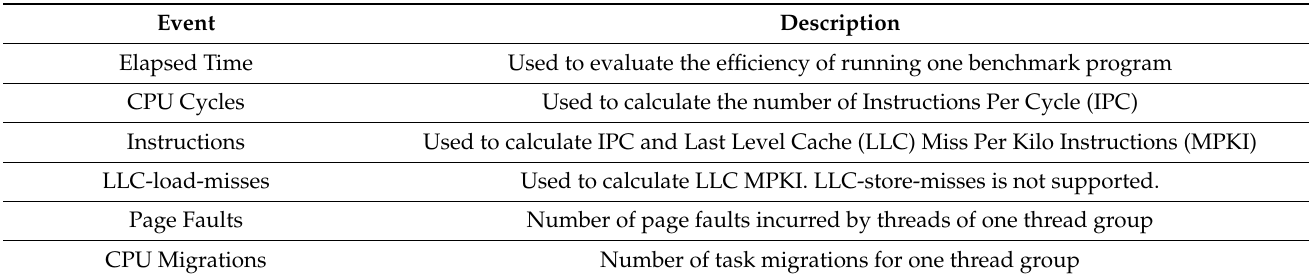
Table 5. Collected performance counter